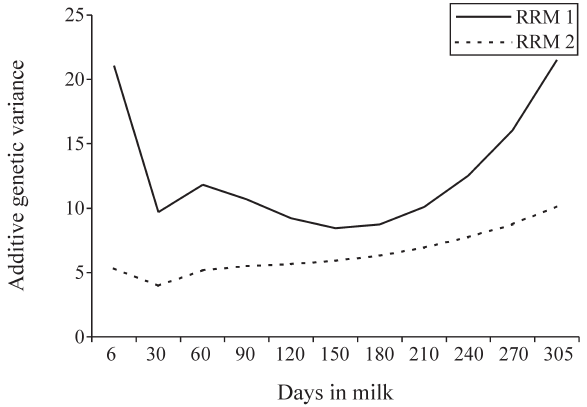
Figure 1 - Additive genetic variances during the different lactation peri- ods estimated by the RRM1 and RRM2 random regression models.